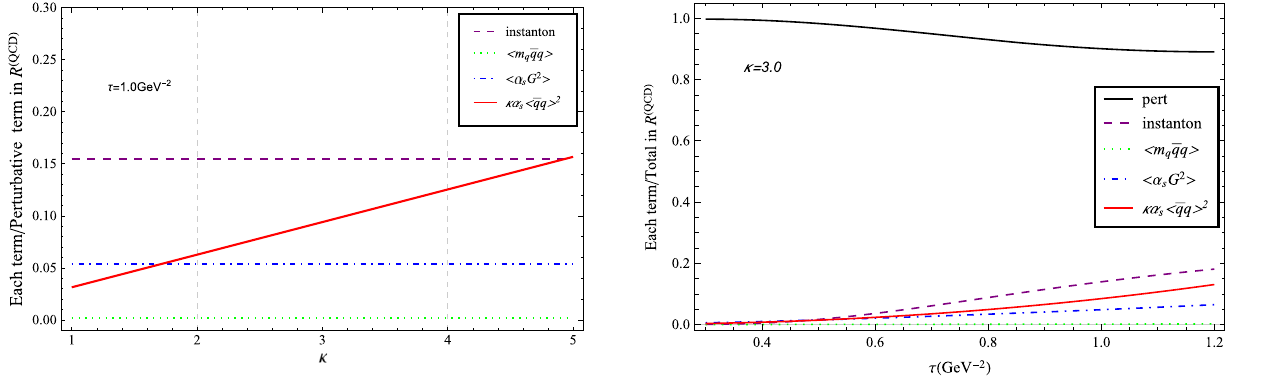
Fig. 4 The τ dependence of the ratios of various terms with respect to the full R ( QCD ) in Eq. (4). The results by taking κ = 3 . 0 are explicitly given here. The curves by taking different values of κ between 2.0 and 4.0 are quantitatively similar, and hence are not explicitly